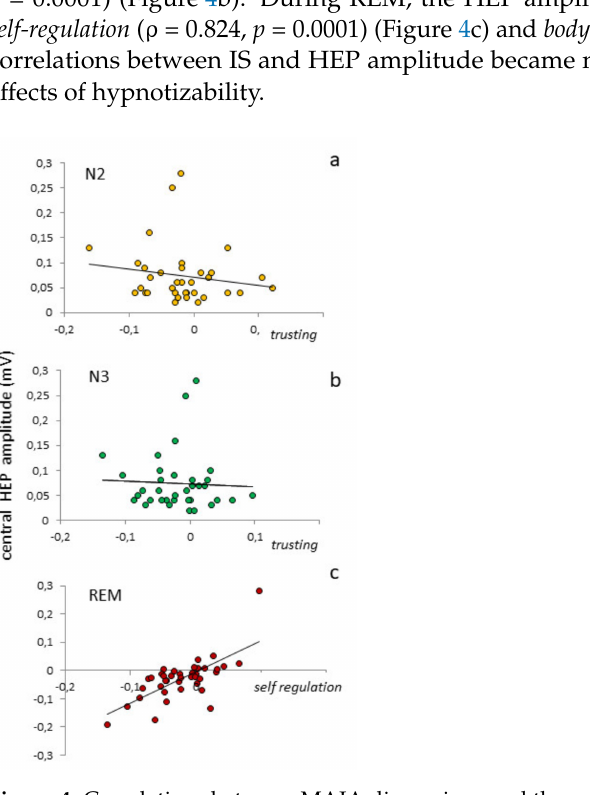
Figure 4. Correlations between MAIA dimensions and the amplitude of the late HEP component at central sites duing N2 ( a ), N3 ( b ) and REM ( c